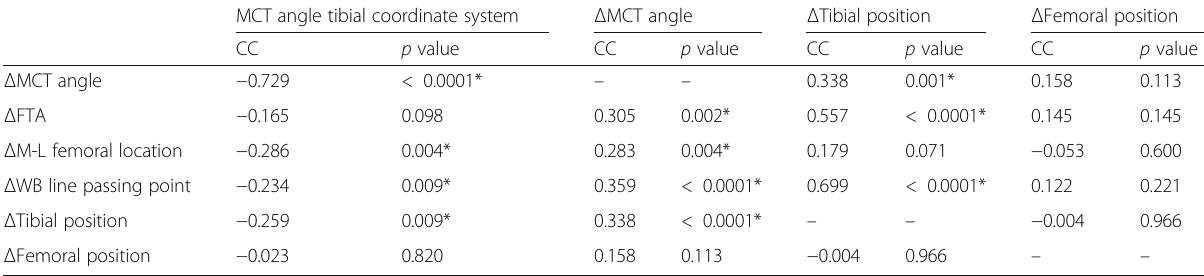
Table 2 Correlation between each parameter MCT angle tibial coordinate